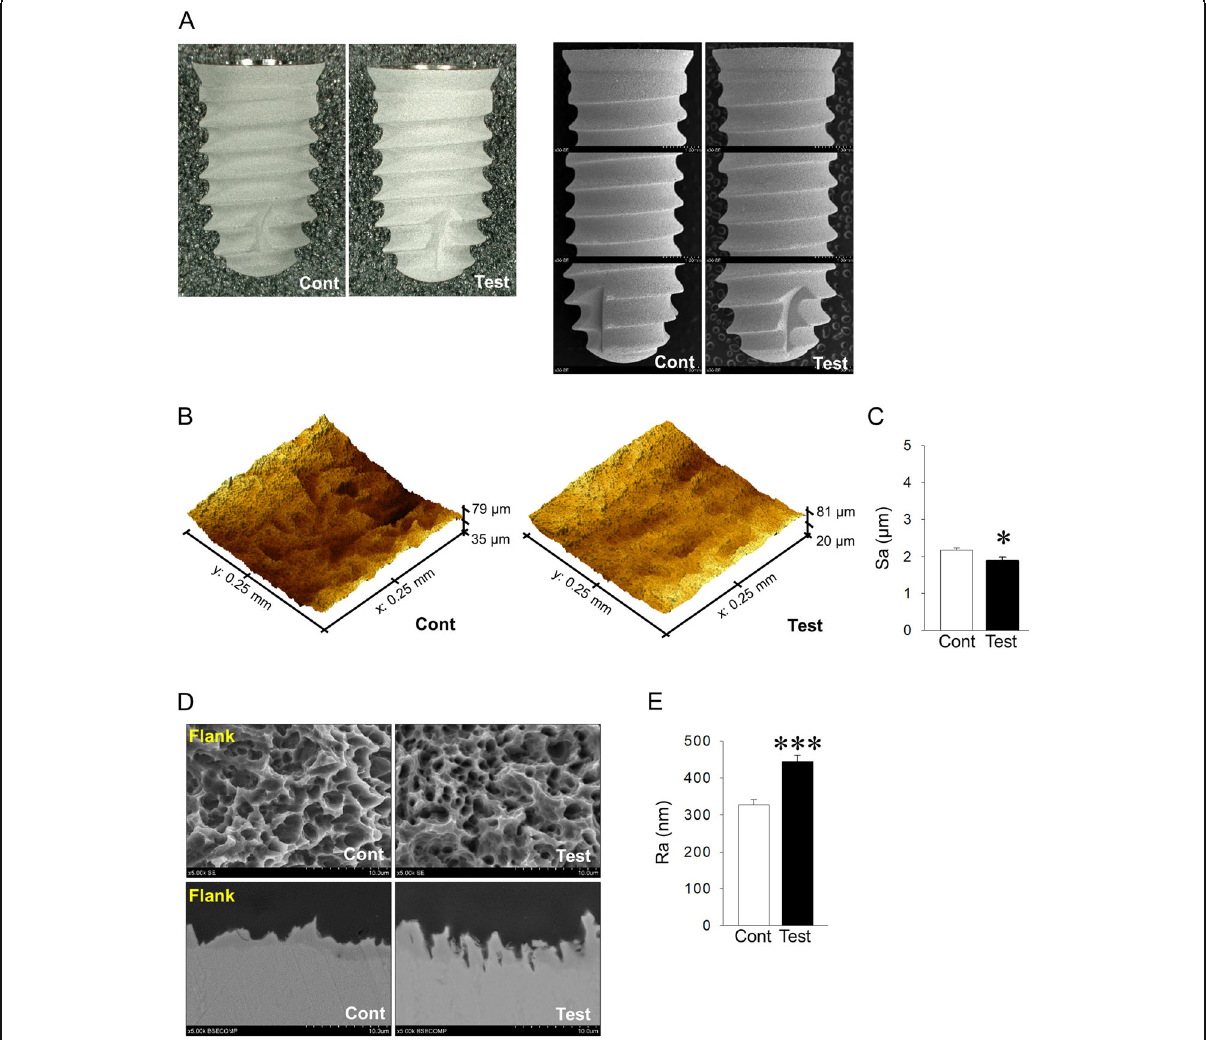
Fig. 2 a Representative digital microscopic and SEM images of control and test implants. b Representative surface images with a confocal laser microscope (Cont: control). c Decreased Sa in test implants when compared with each control (* p < 0.05, n = 10/each group). d Representative surface and cross-sectional images of each implant with SEM under × 5000 magnification (Flank: implant flank). e Increased Ra in test implants compared with each control (*** p < 0.001, n = 10/each